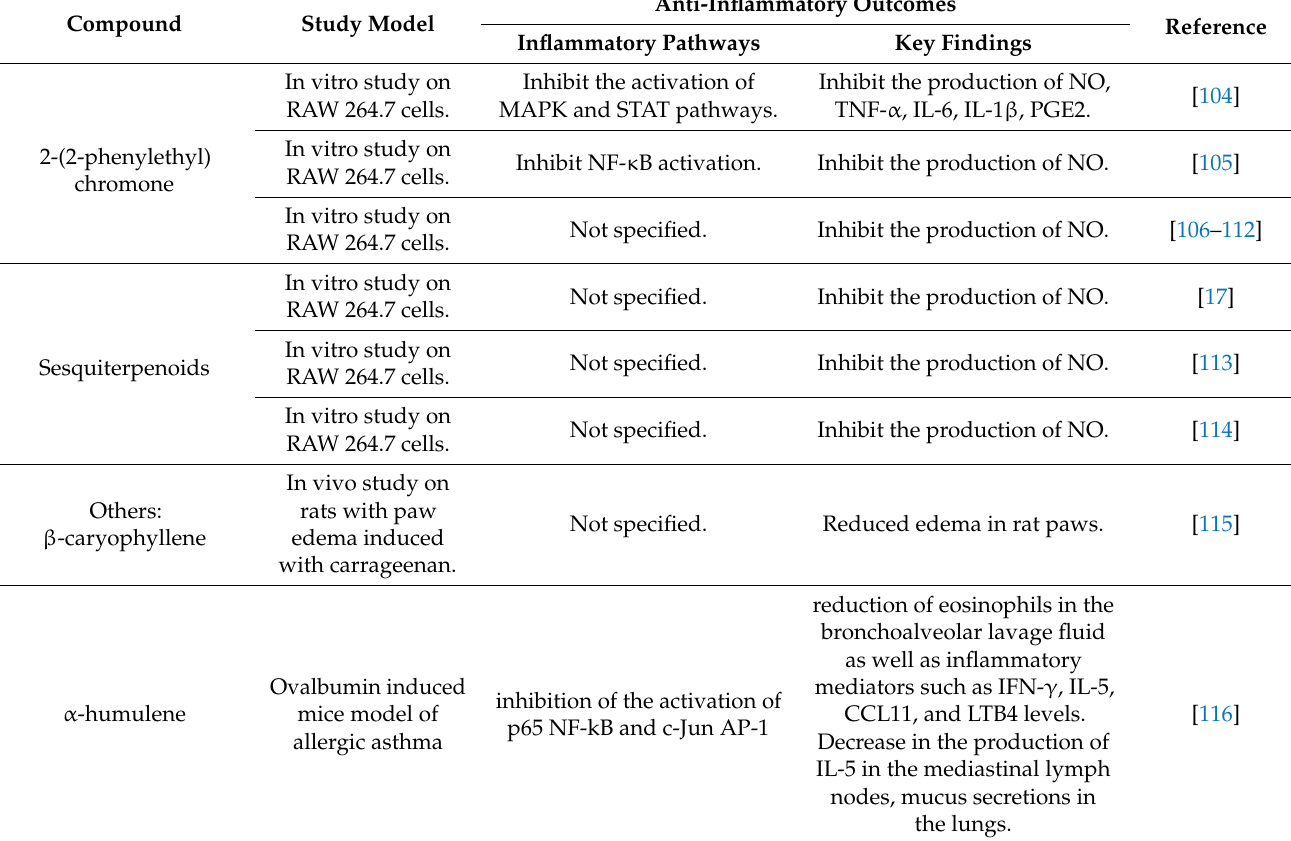
Table 4. Summary of studies on compounds extracted from agarwood with proven anti-inflammatory action.